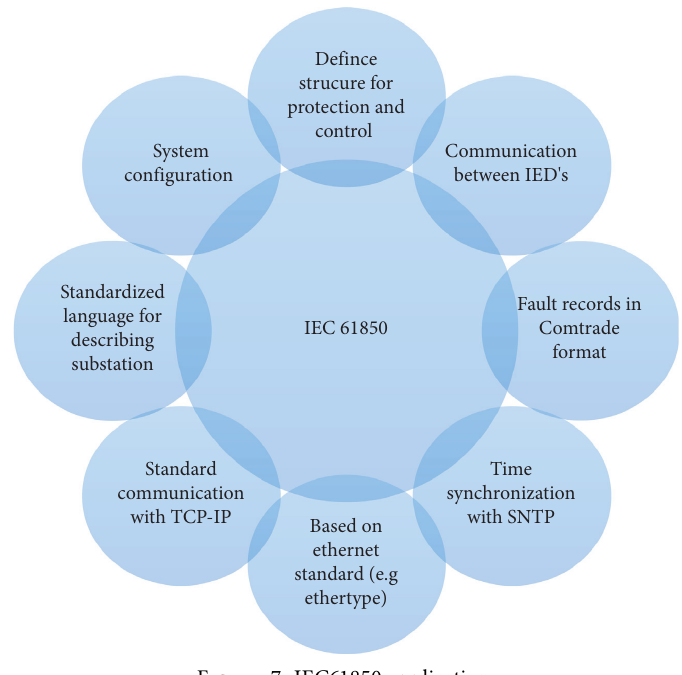
Figure 7: IEC61850 application.